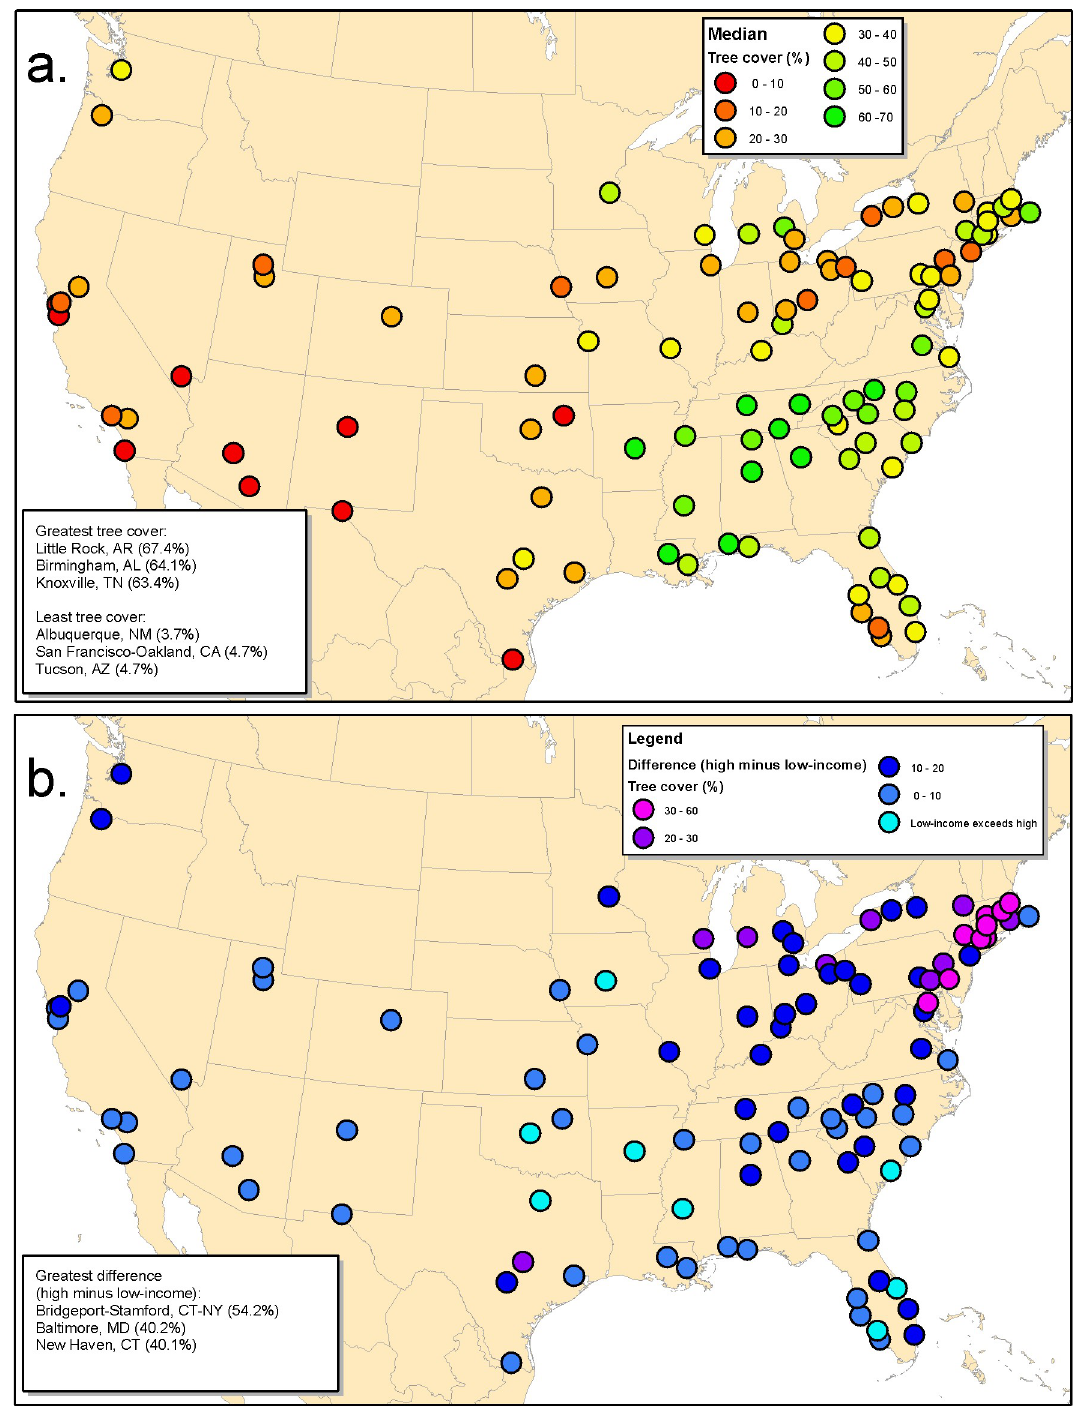
Fig 3. Tree cover for United States large urbanized areas. a.) Population-weighted median tree cover. b.) The absolute difference between low-income blocks (lowest quartile of income) and high-income blocks (highest quartile of income) in tree cover.